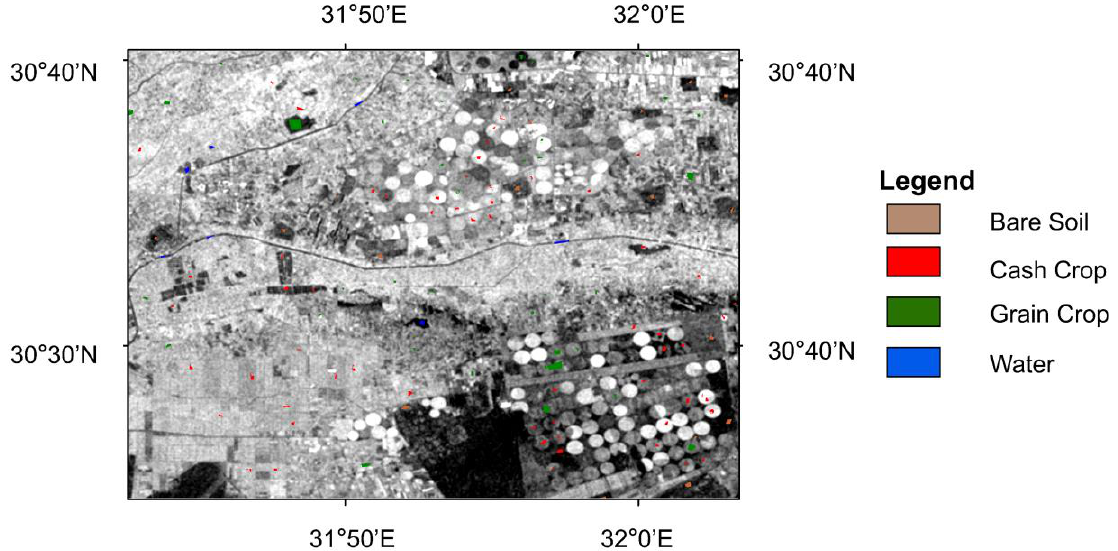
Figure 3. Some samples overlapped on the GLCM-based mean texture features map derived from the Sentinel-1 data VH band (specific parameters refers to Section 3.1.3).